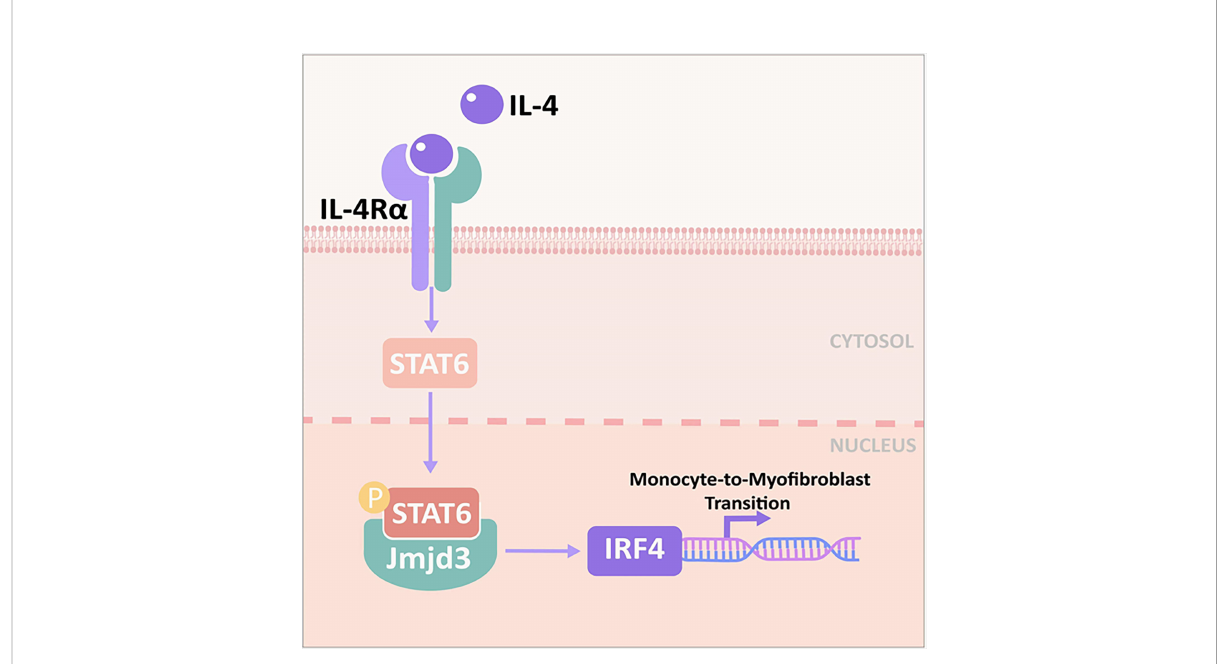
FIGURE 11 Proposed model for the role of Jmjd3/IRF4 axis in IL-4 – induced myeloid activation and kidney fi brogenesis. IL-4 stimulates Jmjd3/IRF4 signaling, leading to monocytes to myo fi broblasts transition and kidney fi